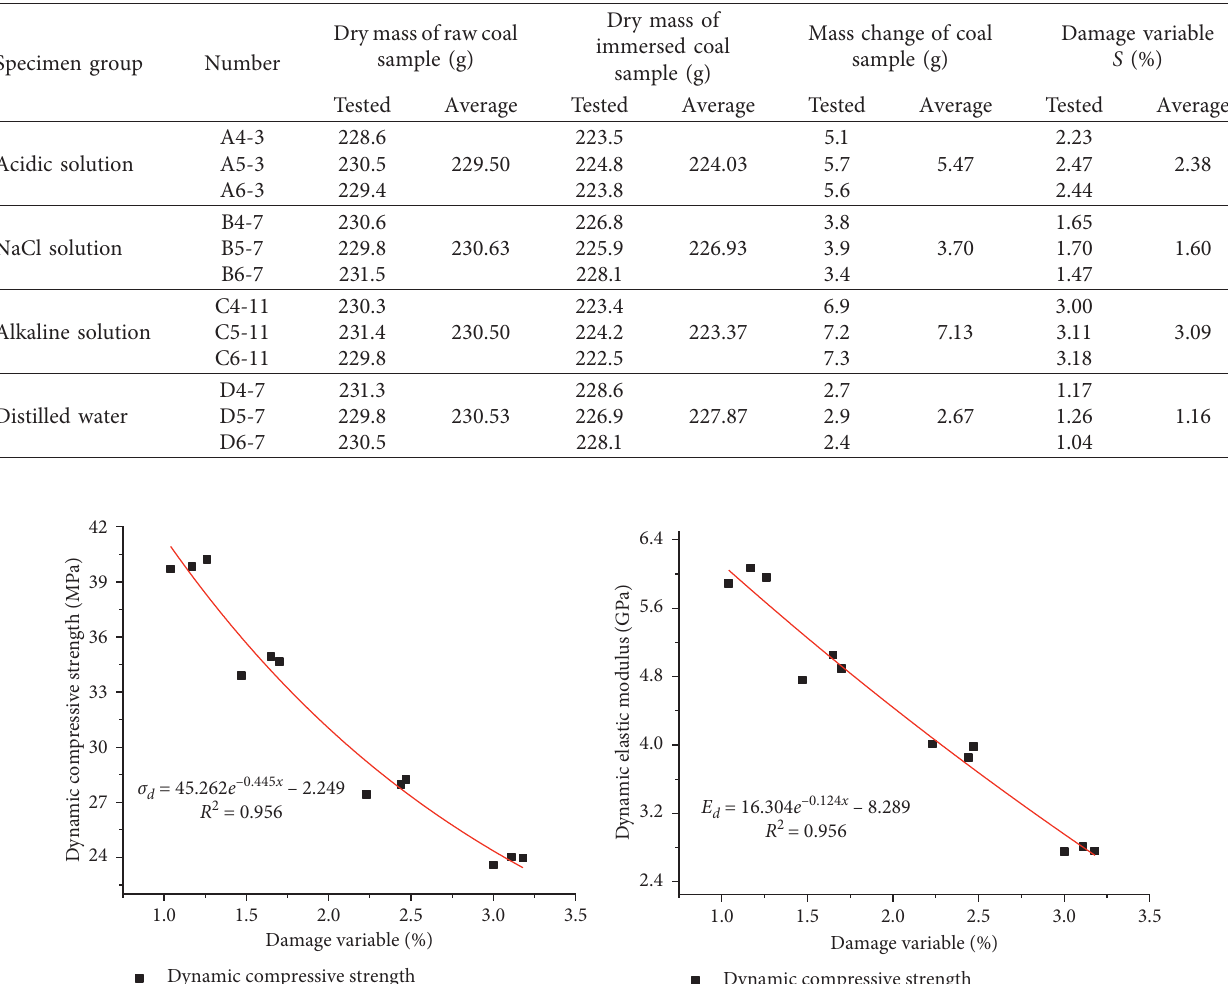
Table 2: Mass parameters of coal samples under dynamic load